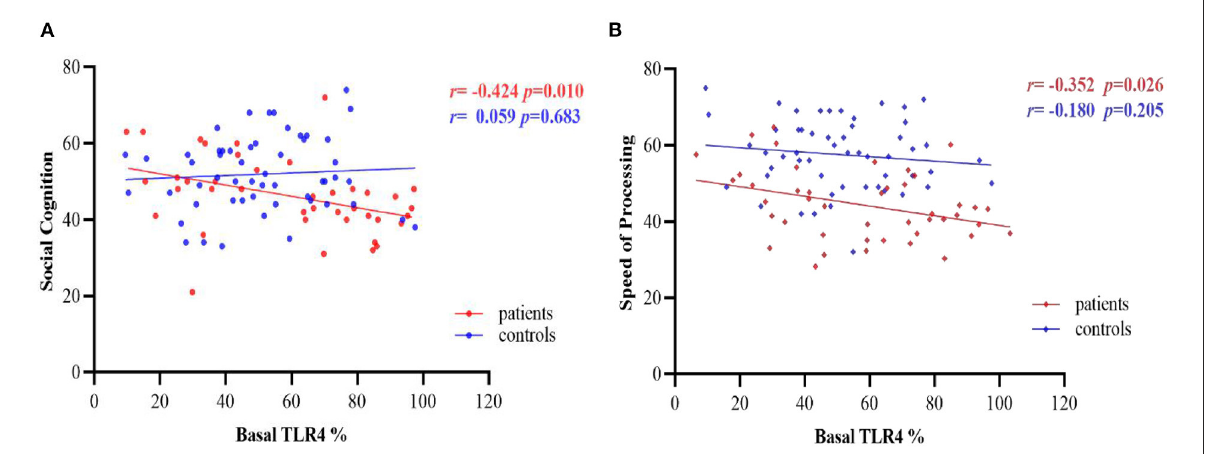
FIGURE4 Partial correlations between basal TLR4 % and cognitive performance in patients and controls group, after adjusting for age, sex, education level and CPZ equivalents. (A) Correlations between basal TLR4 levels and social cognition; (B) Correlations between basal TLR4 levels and speed of processing. TLR4, Toll-like receptor 4. %, The percentage of